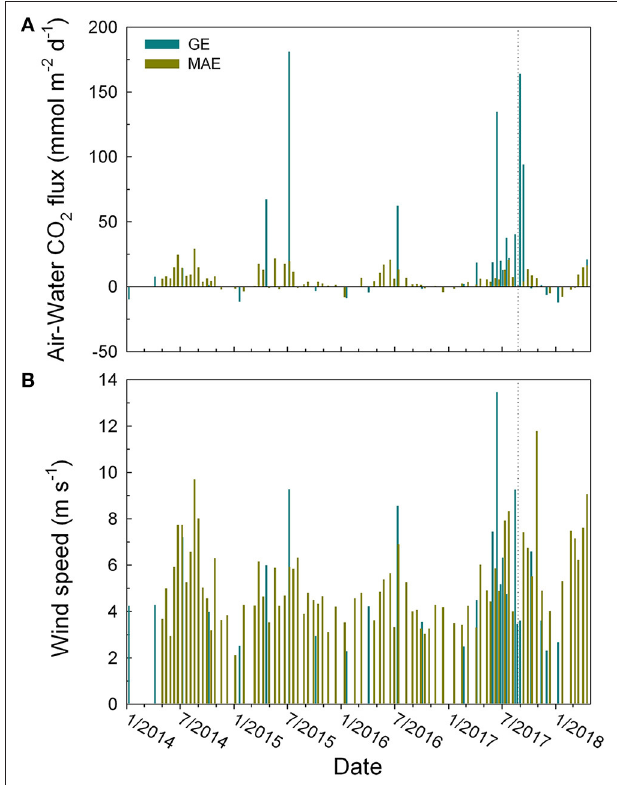
FIGURE 5 | Temporal distributions of (A) air–water CO 2 flux (unit mmol m − 2 d − 1 ) and (B) daily wind speed on the sampling days in GE (dark green) and MAE (dark yellow). The dotted lines represent the date (August 25, 2017) on which Hurricane Harvey made